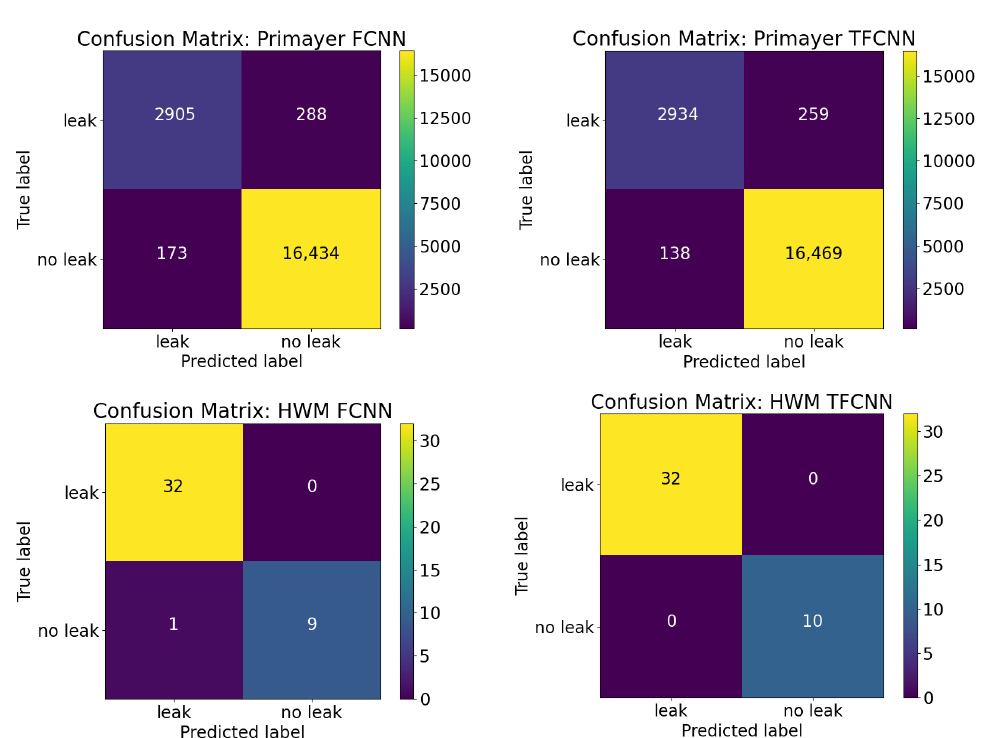
Figure 8. Primayer Enigma ( top ) and HWM PCorr+ ( bottom ) confusion matrices for FCNN ( left ) and TFCNN ( right )